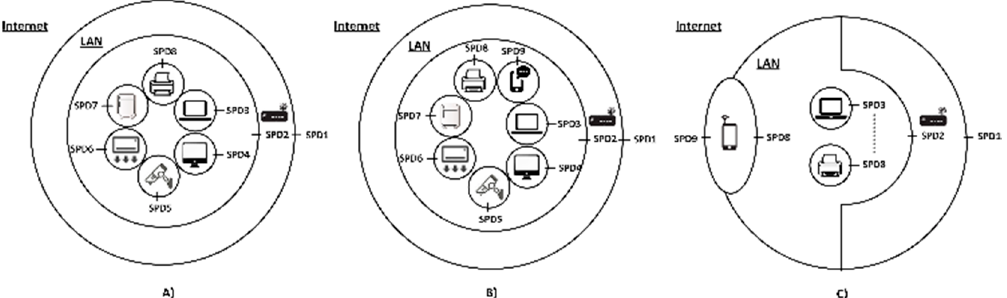
Figure 3. The core composition operations of the medieval castle method. ( A ) represents the current setting of the smart home with 6 devices connecting to a LAN with Internet connection through a router. ( B ) figures the composition of a 7th device to the LAN. ( C ) depicts the direct connect of this device to the Internet.